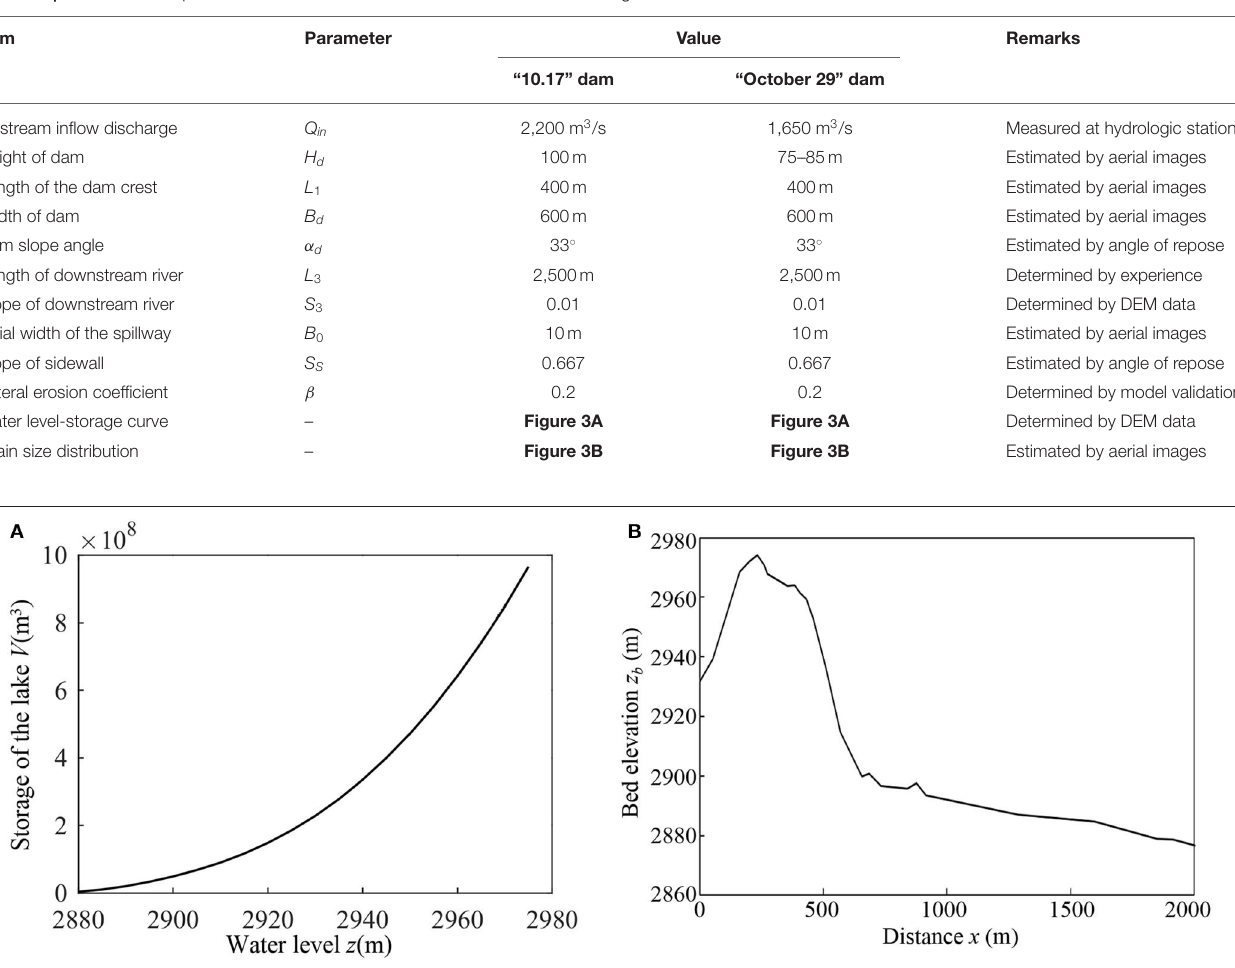
TABLE 1 | Parameters adopted in the breach simulation of the barrier lake in Jiala village. Item